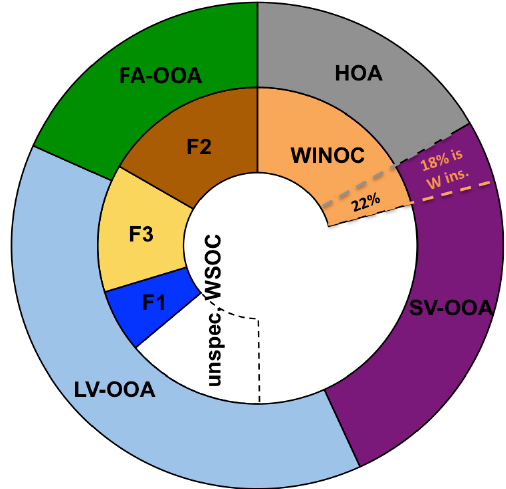
Fig. 8. Organic carbon (OC) amount and comparison between the three different techniques used. Inner circle reports data from NMR and filters analyses; the outer one those from